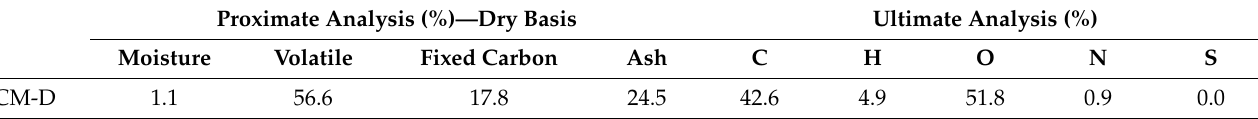
Table 2. Proximate and ultimate analysis of CM-D.